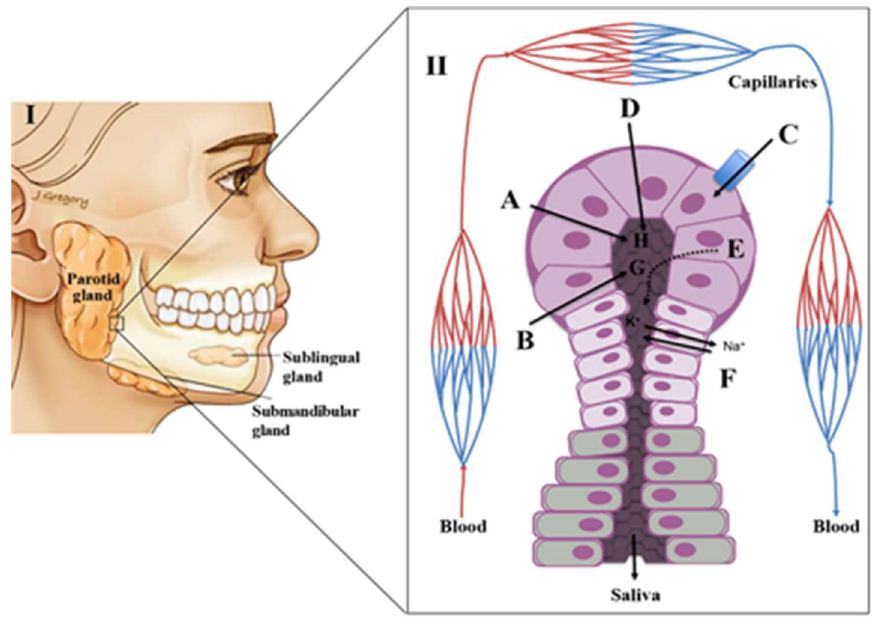
Figure 1. ( I )-The major salivary glands; ( II )–Acini structure and the di ff erent mechanisms of transport Figure 1. ( I ) - The major salivary glands; ( II ) – Acini structure and the different mechanisms of of plasma compounds into a salivary gland. A–Entry of components by simple filtration; B–Entry of transport of plasma compounds into a salivary gland. A - Entry of components by simple filtration; B liposoluble compounds by passive di ff usion C–active transport; D–Active pumping of Na + ions and - Entry of liposoluble compounds by passive diffusion C - active transport; D - Active pumping of concomitant entry of H 2 O; E–component produced / secreted by the salivary glands; F–Pumping of Na+ ions and concomitant entry of H2O; E - component produced/secreted by the salivary glands; F Na + ions into the blood producing hypotonic fluid; G–Liposoluble compounds; H–H 2 O, electrolytes - Pumping of Na+ ions into the blood producing hypotonic fluid; G - Liposoluble compounds; H - (adapted from H 2 O, electrolytes (adapted from [16] ).